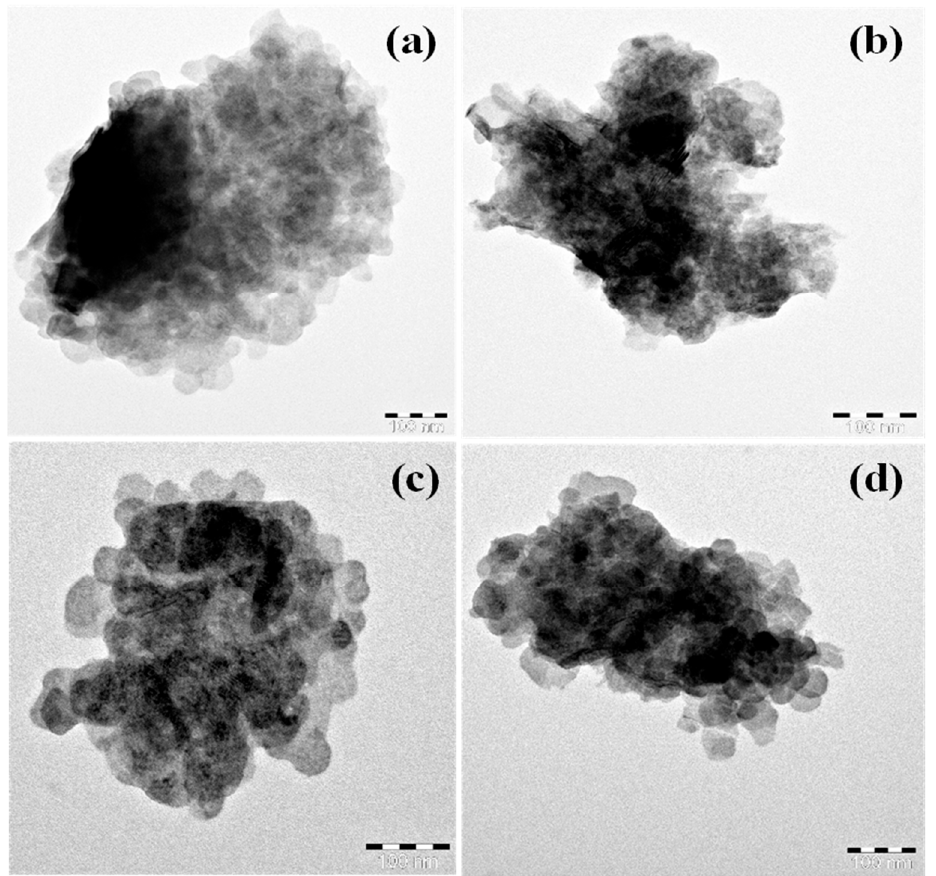
Figure 4. TEM micrographs of ( a ) ZnFe 2 O 4 , ( b ) ZnW 0.05 Fe 1.95 O 4 , ( c ) ZnW 0.1 Fe 1.90 O 4 , and ( d ) ZnW 0.15 Fe 1.85 O 4 . Table 1. Cell dimension a (Å), crystallite size (nm) and microstrain ( ε ) of the ZnW x Fe 2 − 2x O 4 system. Parameter x = 0.0 x =